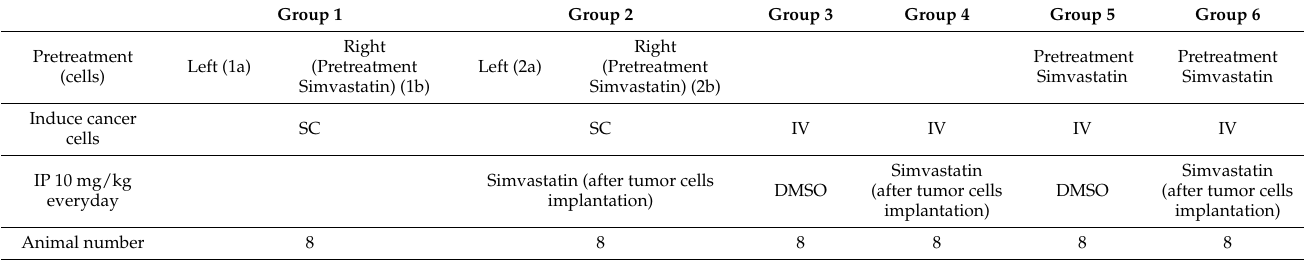
Table 1. Different simvastatin treatments in animal